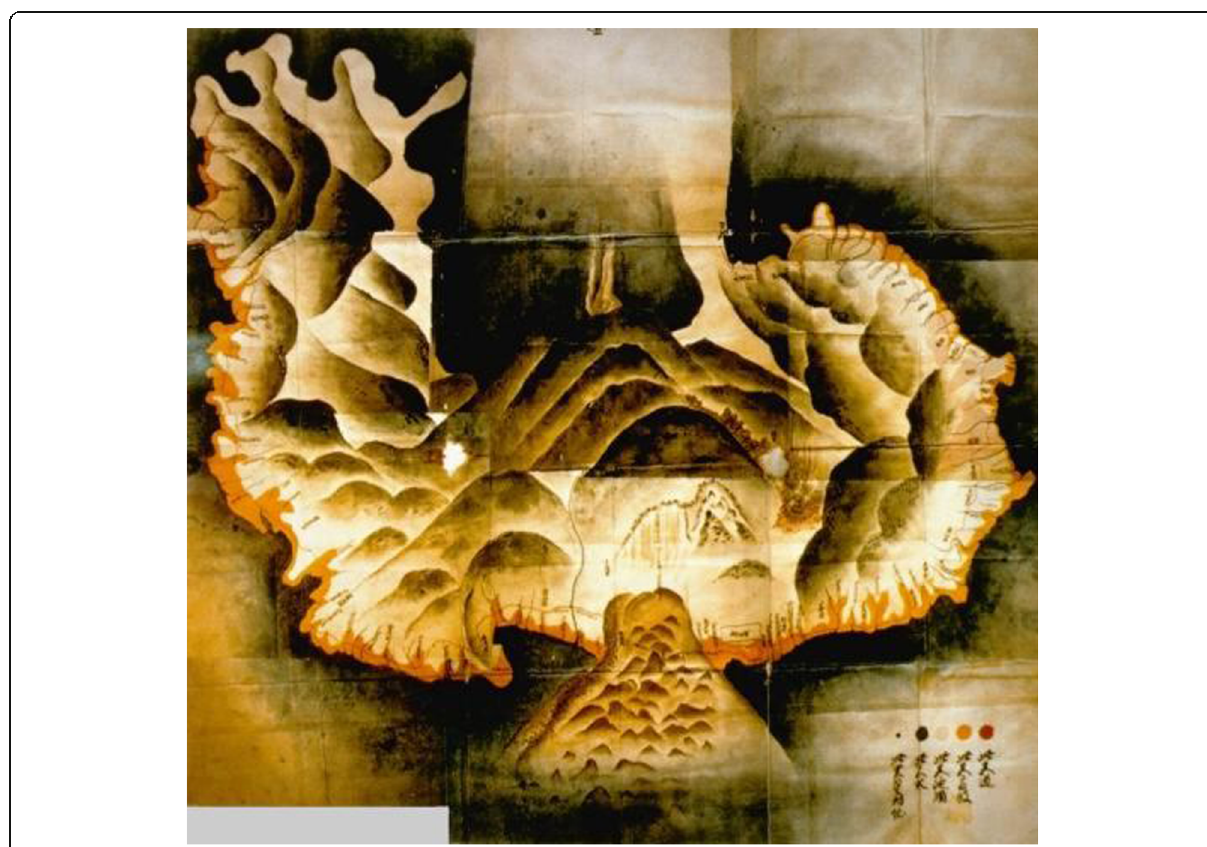
Fig. 21 Map of the Shimabara Peninsula, showing Unzen volcano and the Mayuyama debris avalanche. Upon entering the sea, the landslide created a tsunami which caused about 15,000 human casualties along the coastline (Global Volcanism